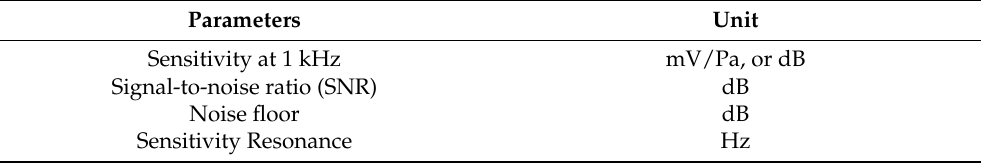
Table 1. The main parameters and relative units for acoustic sensor performance.